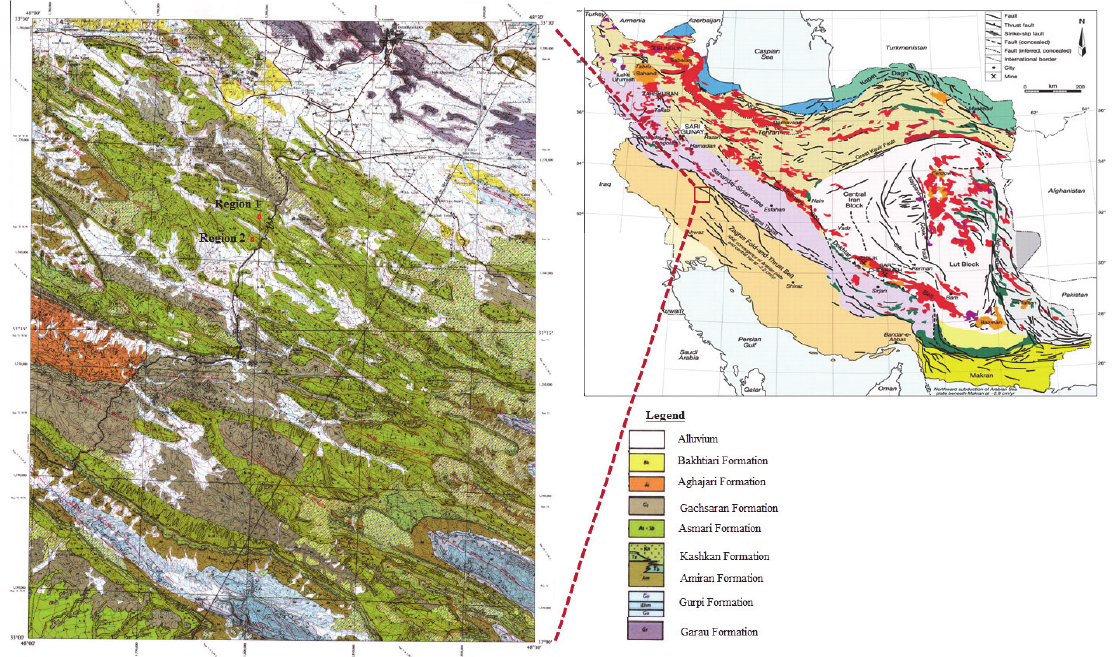
Figure 1: The geological map and the location of the two study